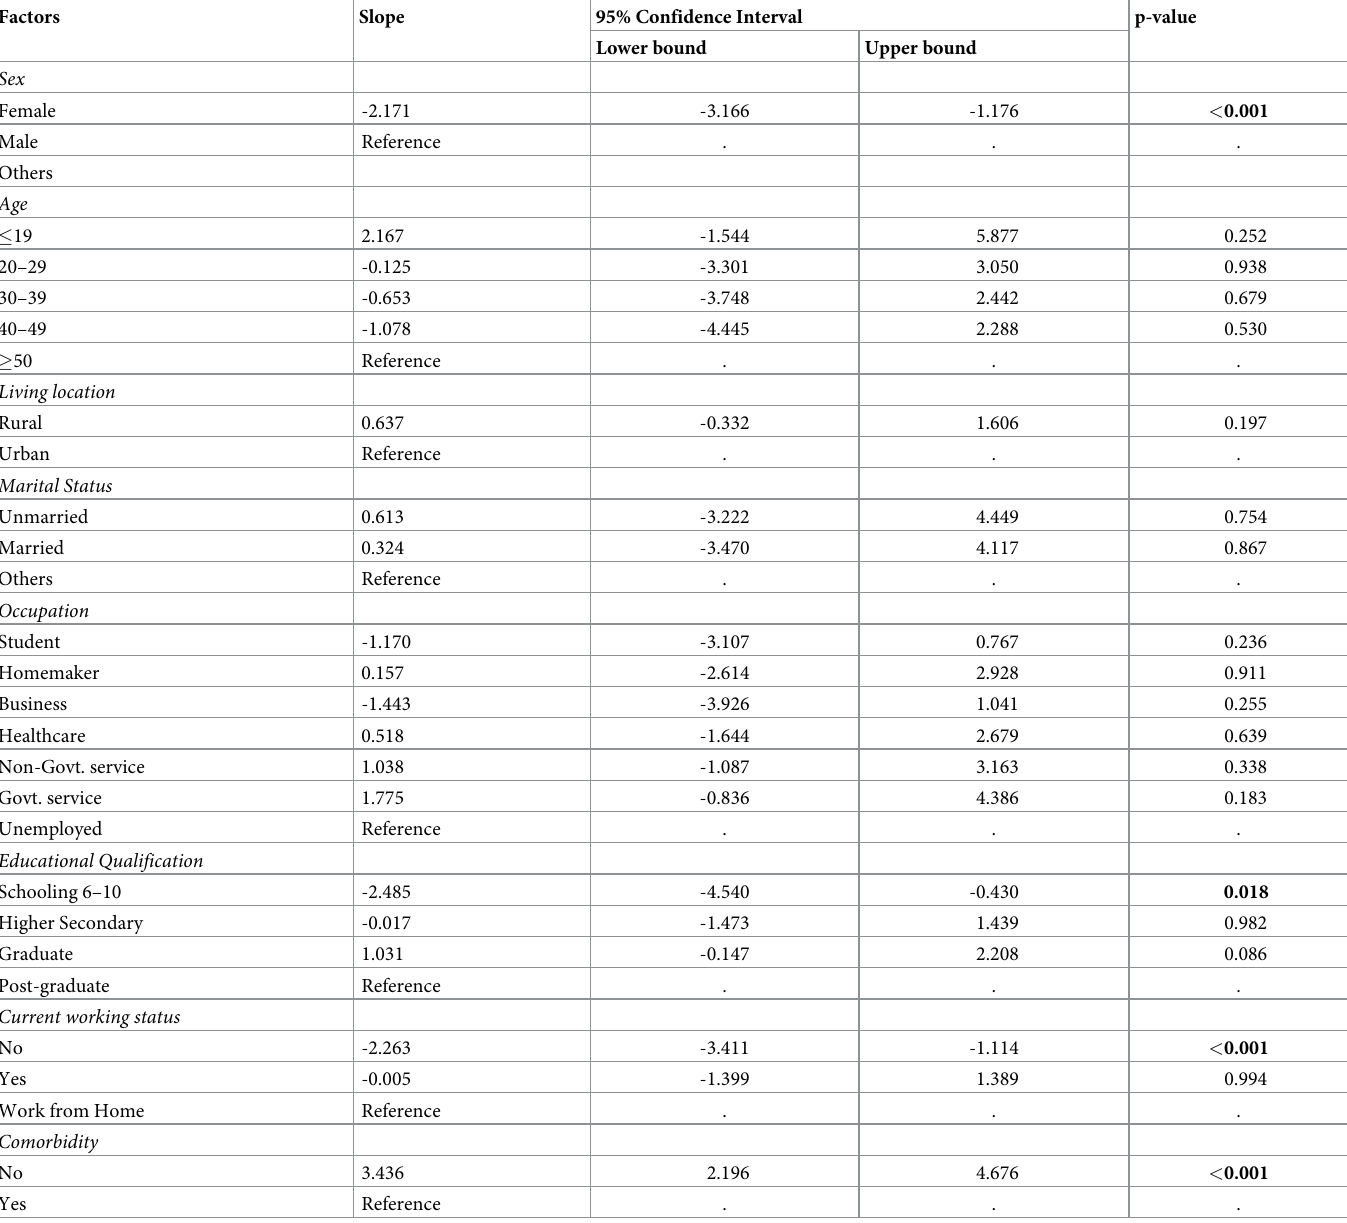
Table 2. Results from a multivariable linear regression model with well-being score as the outcome. (The positive slope means better mental